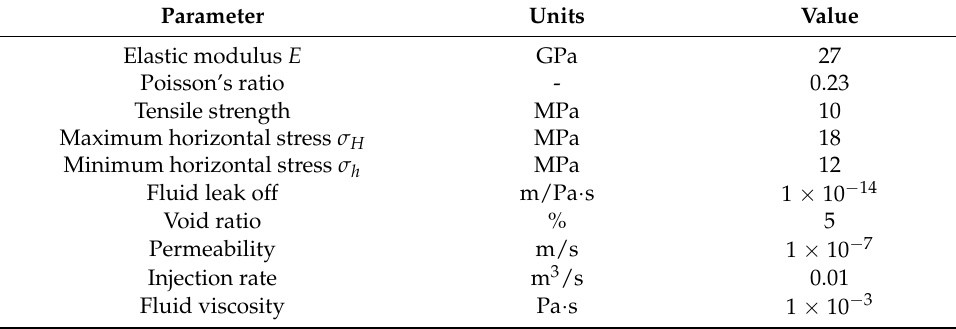
Table 1. Simulation parameters.